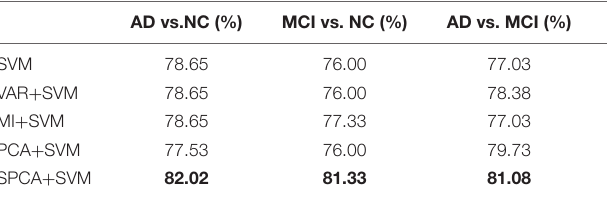
TABLE 2 | Recognition accuracy of dimensionality reduction